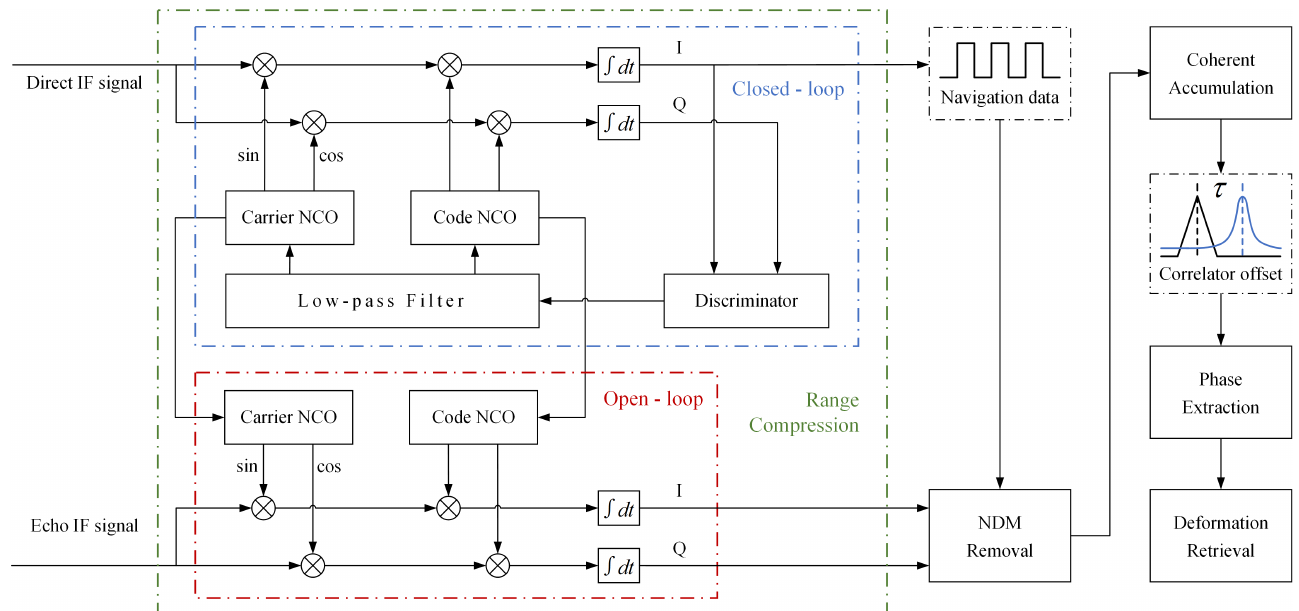
Figure 3. Schematic of software defined receiver and processing